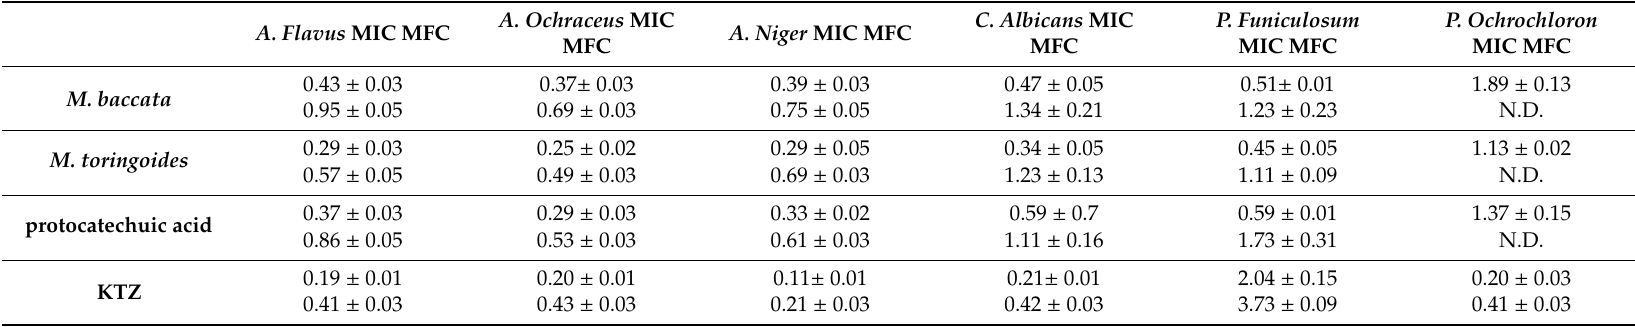
Table 5. Minimum inhibitory (MIC) and fungicidal concentration (MFC) of Malus baccata and Malus toringoides bark extracts as well as protocatechuic acid. Values are means of 3